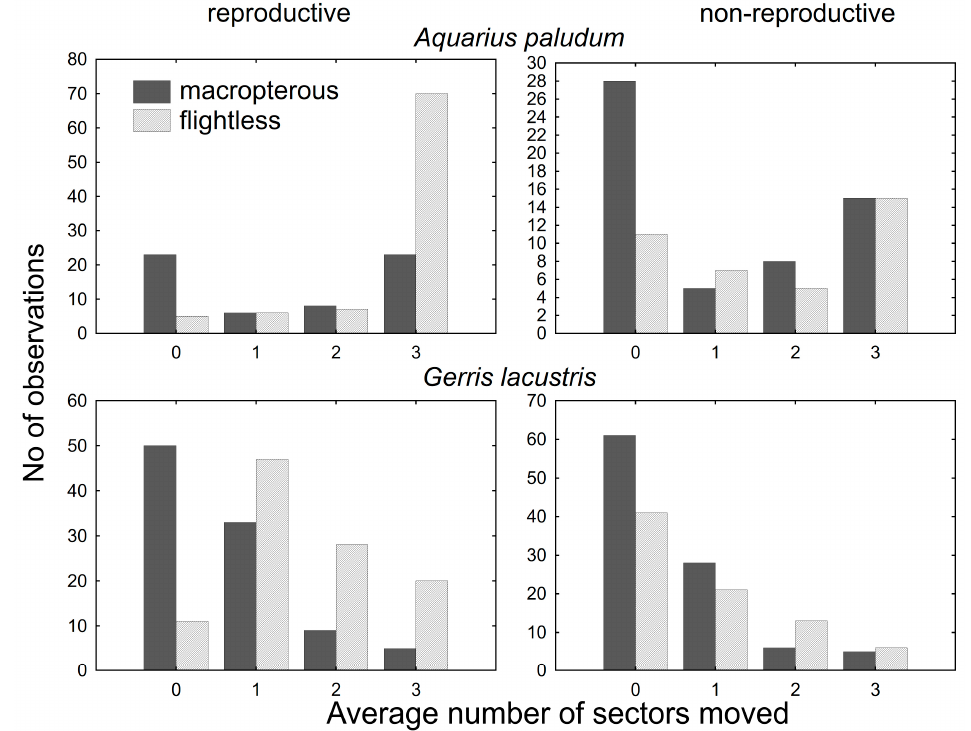
Figure 3. The score of within-site movement in wing-dimorphic reproductive and non-reproductive females of A. paludum and G. lacustris . In both species, the most dispersed are flightless reproductive females, although the number of passed sectors differs.